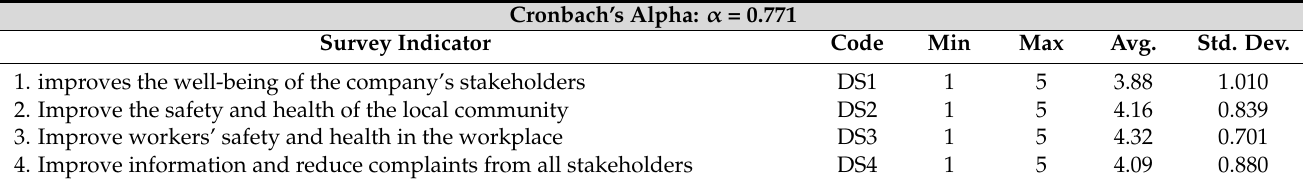
Table 5. Descriptive Statistics of the variable “Social Performance” survey indicators.